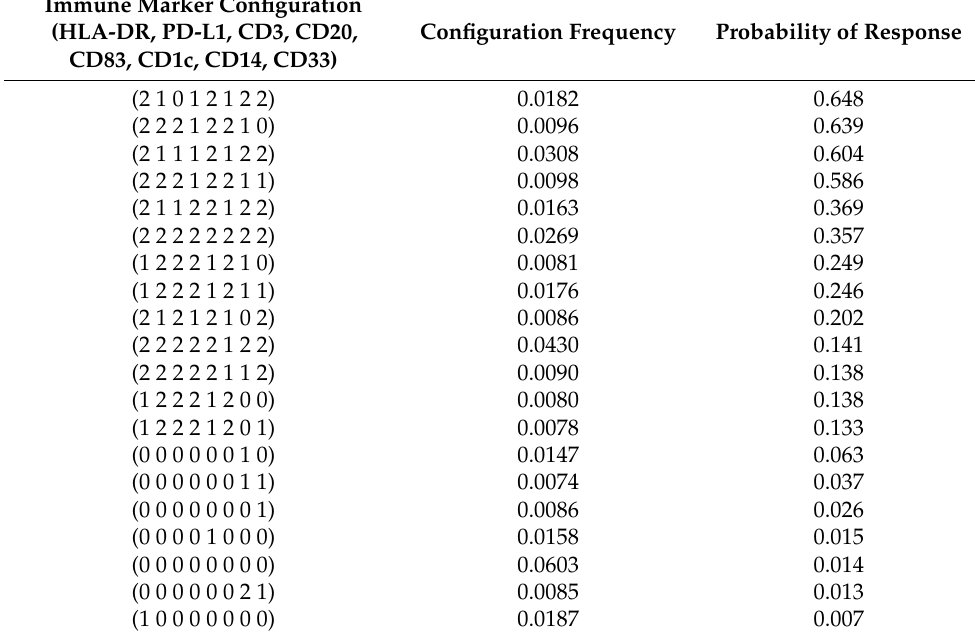
Table 2. The 20 most frequent predictive immune marker configurations (Innate FACS panel), in descending order of probability of response. First column shows predictive immune marker configurations obtained from the MN of the response status variable, eight markers in total (HLA-DR, PD-L1, CD3, CD20, CD83, CD1c, CD14, CD33). The values “0”, “1”, “2” in the first column indicate “low”, “medium” and “high” values after discretization. Second column shows configuration frequency; third column—probability of